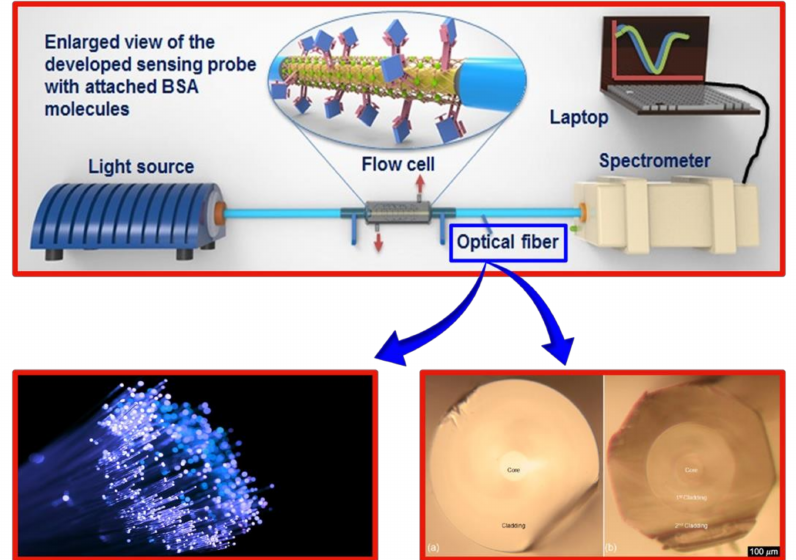
Figure 2. Layout of an OFS. Right side shows microscopic cross-section images of the double-coated optical fibers. ( a ) in the passive fiber the transition from the inner to the outer cladding occurs at a lower RI; ( b ) octagonal cross section of the second cladding of the active doped fiber [8,9].